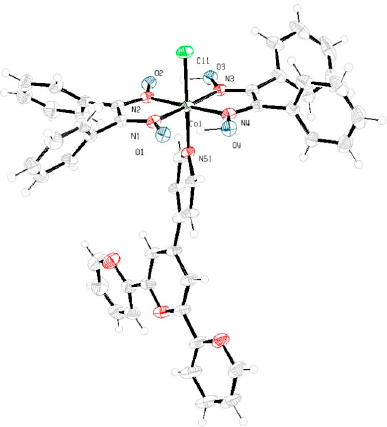
Figure 5. Oak Ridge Thermal Ellipsoid Plot (ORTEP) of [CoCl(dpgH) 2 (pytpy)] (50% probability displacement ellipsoids). Table 2. Selected bond lengths and bond angles for [CoCl(dpgH) 2 (pytpy)].